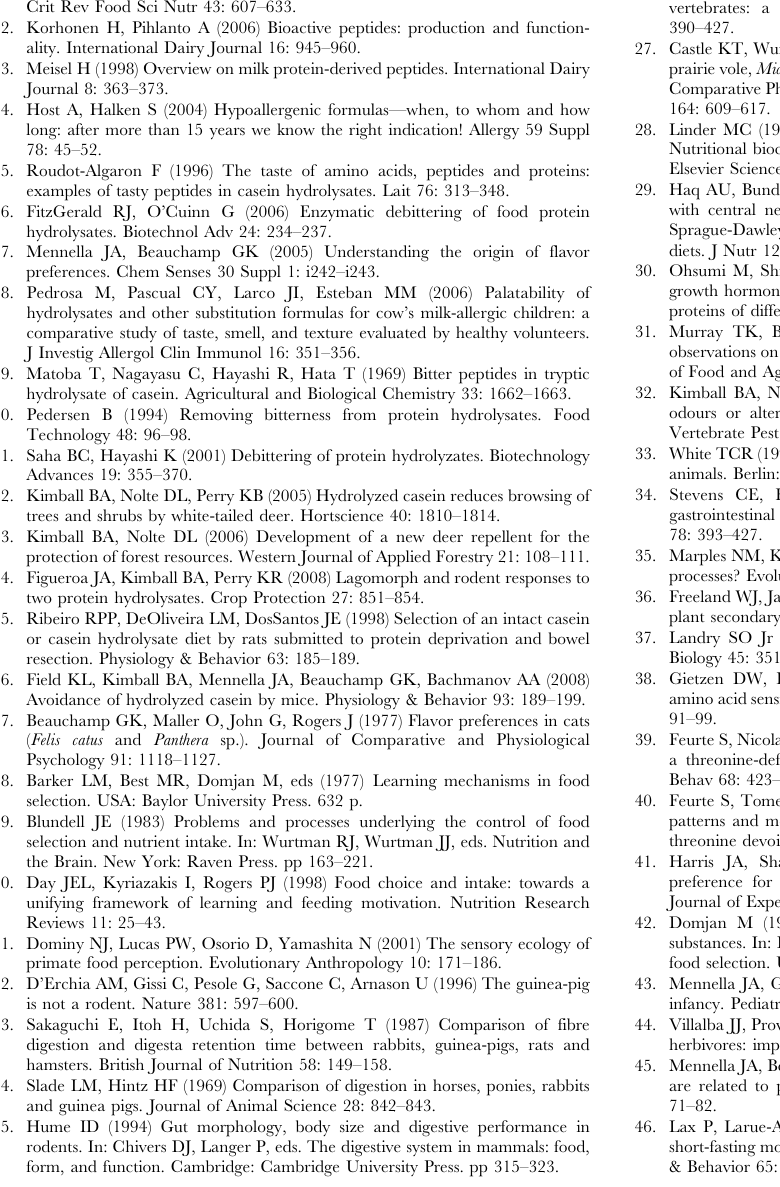
nance; BWs taken 2–3 d apart. Figure S2 Individual body weights (g) of rats (top) and guinea pigs (bottom). BW1 was taken as a baseline, following arrival to the facility; BW2 was taken after the Training diets, BW3 was taken after the HC tests, BW4 was taken after the GE tests; BWs taken once per week; note the different y-axis scales. For the rats, all males were heavier than females by the end of the experiment (BW3 and BW4 measurements correspond to ages 5.5 and 6.5 weeks, when sexual size dimorphism develops for this strain of rat). Found at: doi:10.1371/journal.pone.0004126.s002 (1.88 MB TIF)